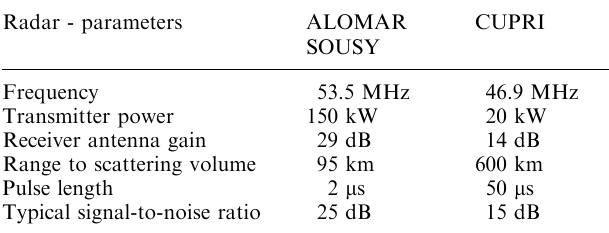
Table 1. Operating parameters for two di(cid:128)erent 50-MHz radars Radar - parameters ALOMAR